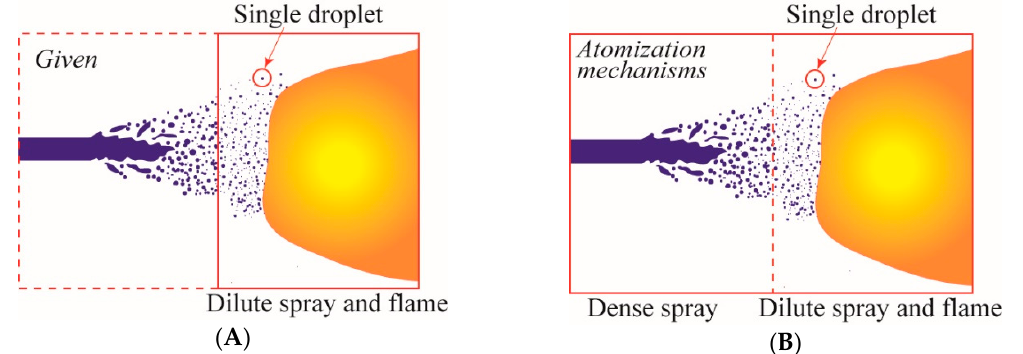
Figure 1. Schematic images of conventional ( A ) and ideal ( B ) spray combustion simulation approaches [14]. The region marked by the solid square is the actual computational domain. In the left figure, “given” does not necessarily mean that the given model is physically accurate.